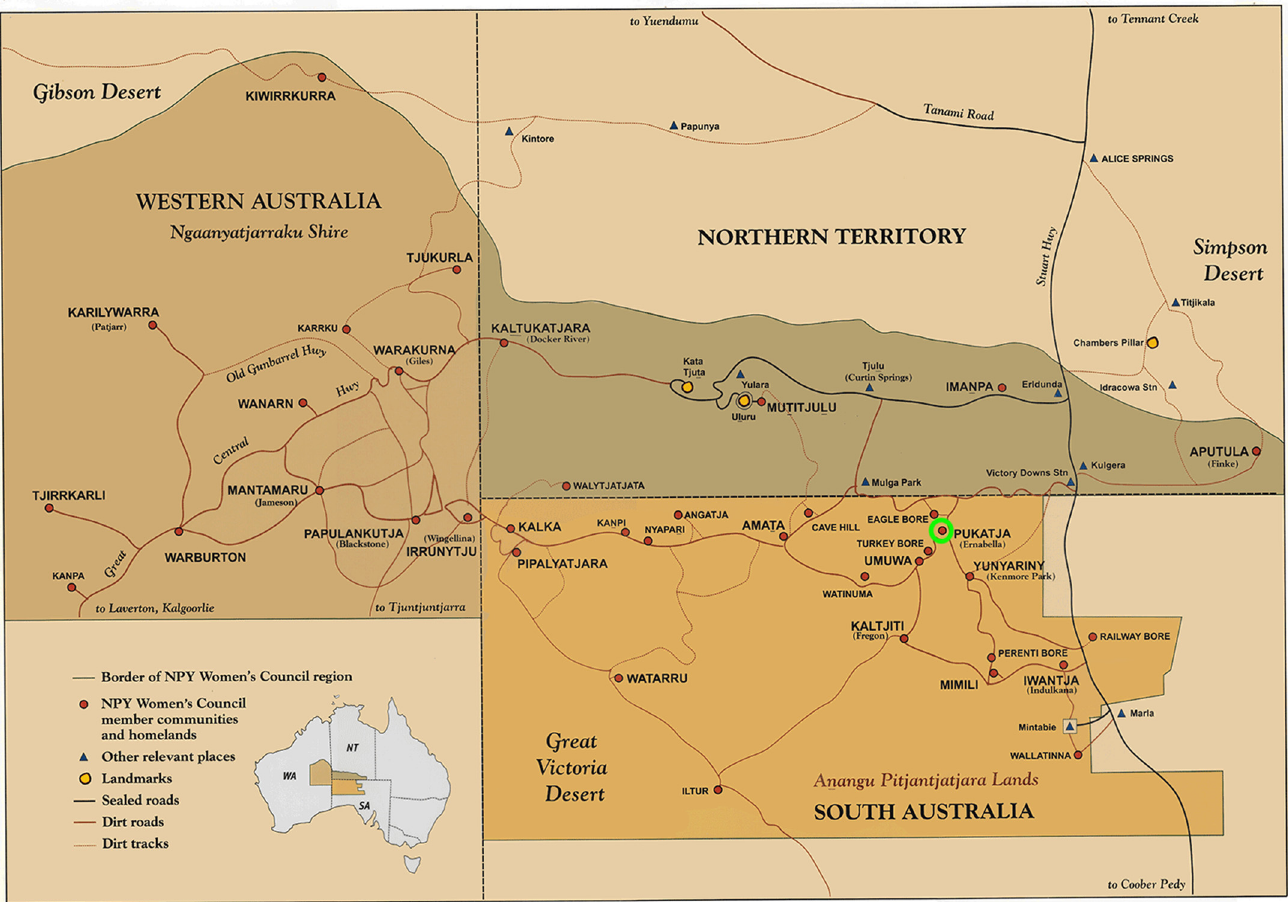
Figure 1. Map of Ngaanyatjarra Pitjantjatjara Yankunytjatjara (NPY) Region, used with permission from NPY Women’s Council (https://www.npywc.org.au/about/ (accessed on 1 April 2021). The location of Pukatja is highlighted in green.